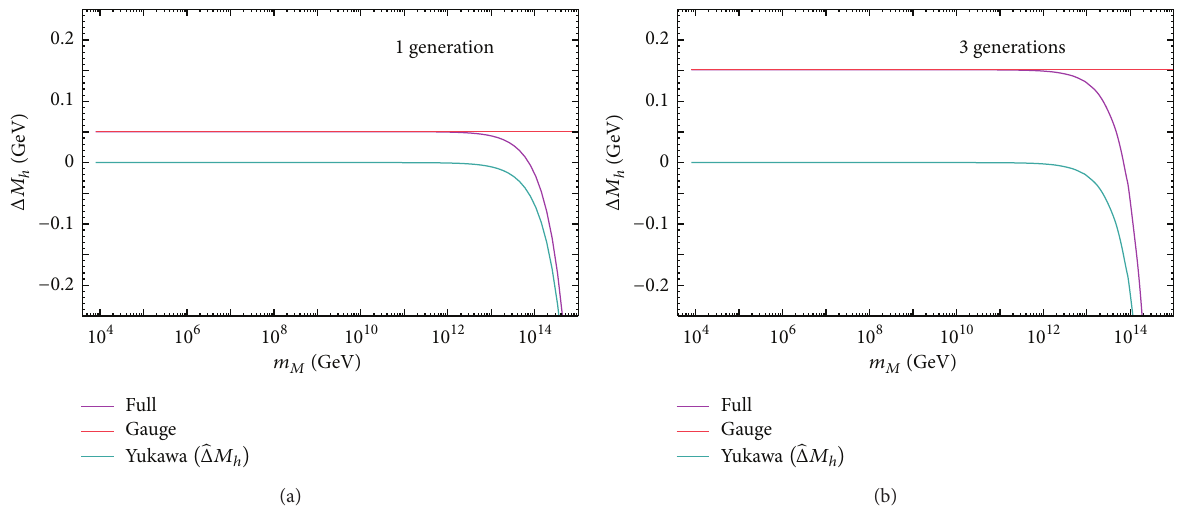
Figure 3: (a) Δ𝑀 ℎ as a function of 𝑚 𝑀 for the one generation case. (b) Δ𝑀 ℎ as a function of the scale 𝑚 𝑀 for the degenerate three generations case. The rest of the model parameters are set as in